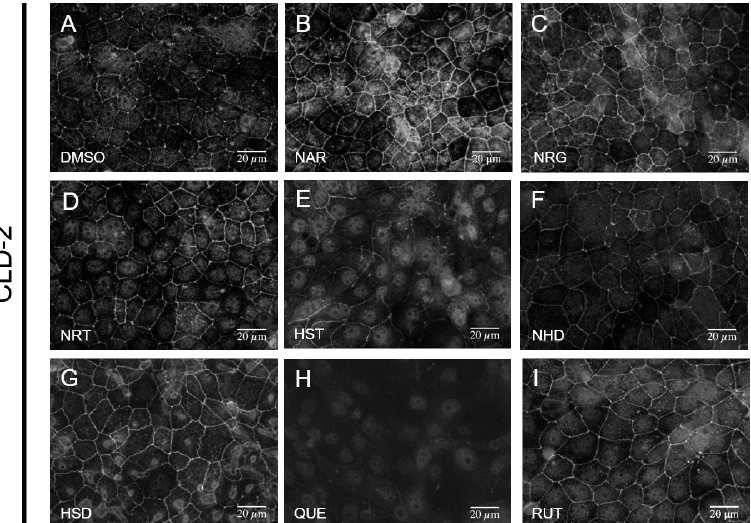
Figure 3. Effects of flavonoids on tight junction integrity of MDCK II cells. Immunofluorescence staining of CLD-2 images are arrayed. Cells were treated with flavonoids at a concentration of 100 μM for 48 h. ( A ) control (DMSO), ( B ) NAR, ( C ) NRG, ( D ) NRT, ( E ) HST, ( F ) NHD, ( G ) HSD, ( H ) QUE, and ( I ) RUT. Scale bar = 20 μM. Brightness is modified to 160%. MDCK: Madin–Darby canine kidney,